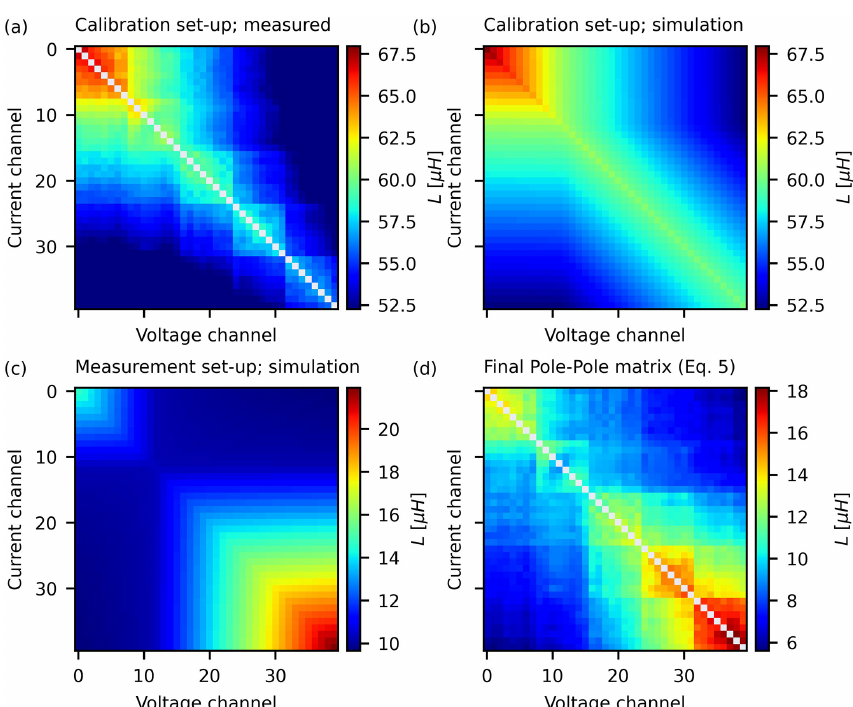
Figure 7. (a) Pole–pole matrix of the inductive calibration measurements. Missing electrode rows and columns were filled with a 2D linear interpolation. (b) Result of numerical simulation of calibration setup. (c) Result of numerical simulation of the measurement setup. (d) Final pole–pole matrix computed from calibration measurements and numerical simulations using Eq. (5).